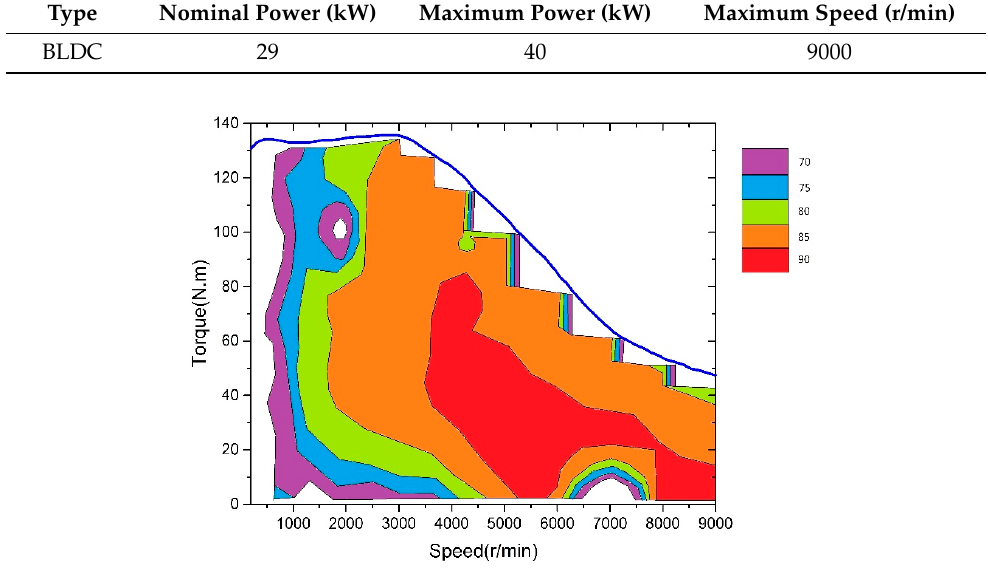
Figure 5. Efficiency map of the electric motor. 176